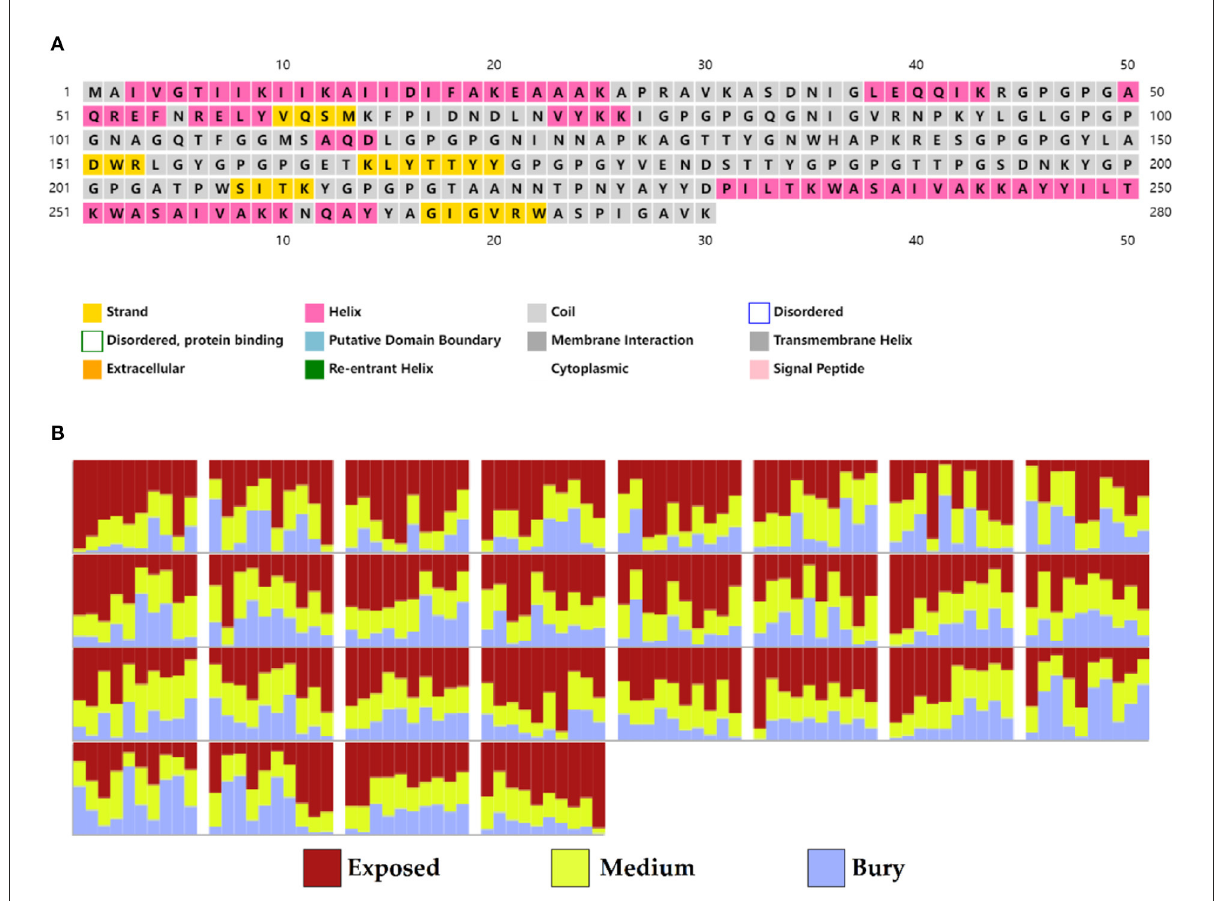
FIGURE5 Secondary structure prediction of the vaccine protein sequence by using PSIPRED and RaptorX server showing (A) secondary structural elements and (B) solvent accessibility according to three states.